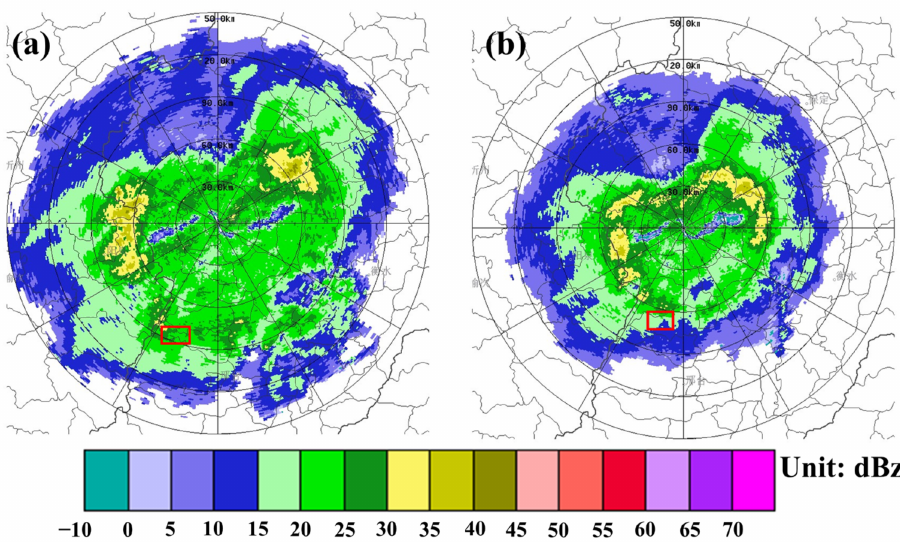
Figure 3. 22 May 2017 ( a ) 17:30, 2.4 ◦ elevation angle PPI, ( b ) 17:54, 3.4 ◦ elevation angle PPI. The red rectangle box is the aircraft detection